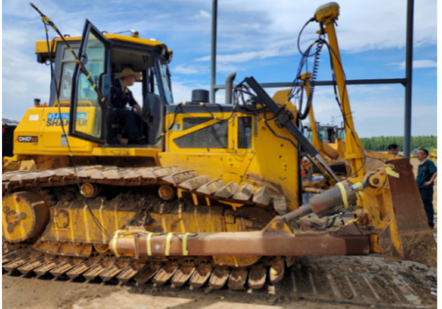
Figure 13. The complete dozer after installing the strain gauges.